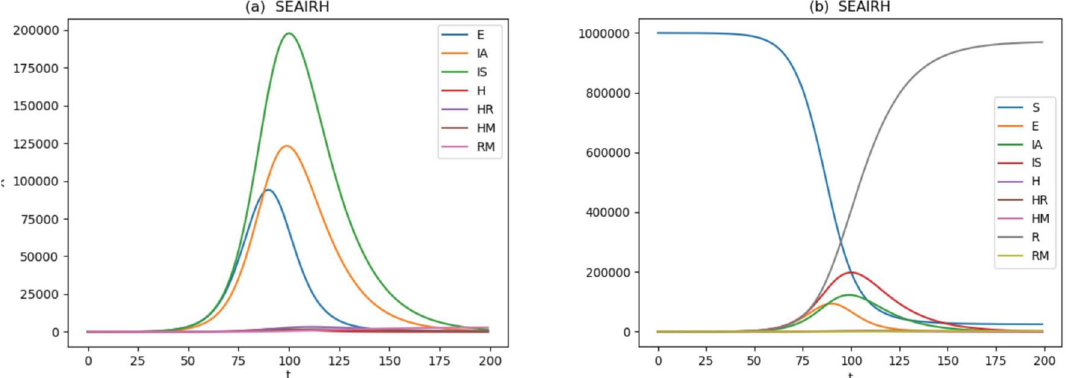
Figure 5. The evolution of the model given the apparent doubling time represented by the regression in Fig. 3a. The peaks in variables in ( a ) show lagging as the compartments move through their sequence. The susceptible and recovered variables are included in ( b ).